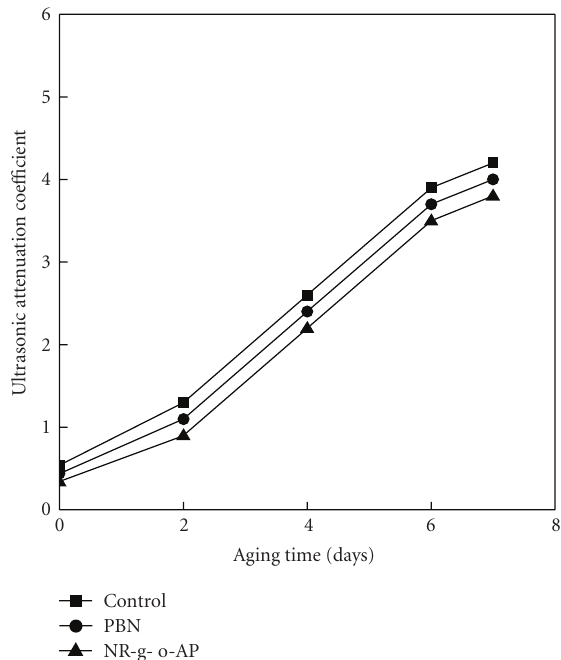
Figure 10: Relation between ultrasonic attenuation coe ffi cient and aging time for NBR vulcanizates containing PBN and NR-graft- o - AP.